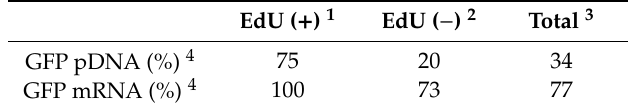
spheroids. 4 More than 150 cells in 4 wells were evaluated for each group.